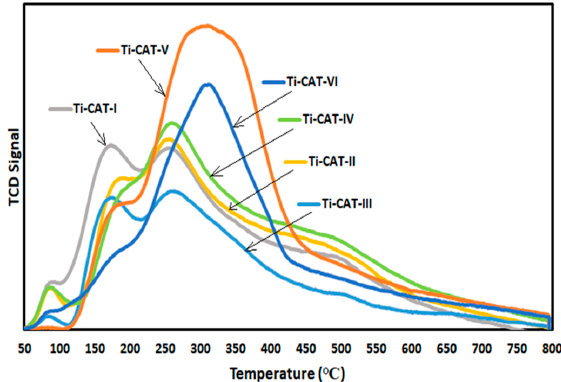
Figure 1. CO 2 -TPD profiles of the synthesized catalysts.